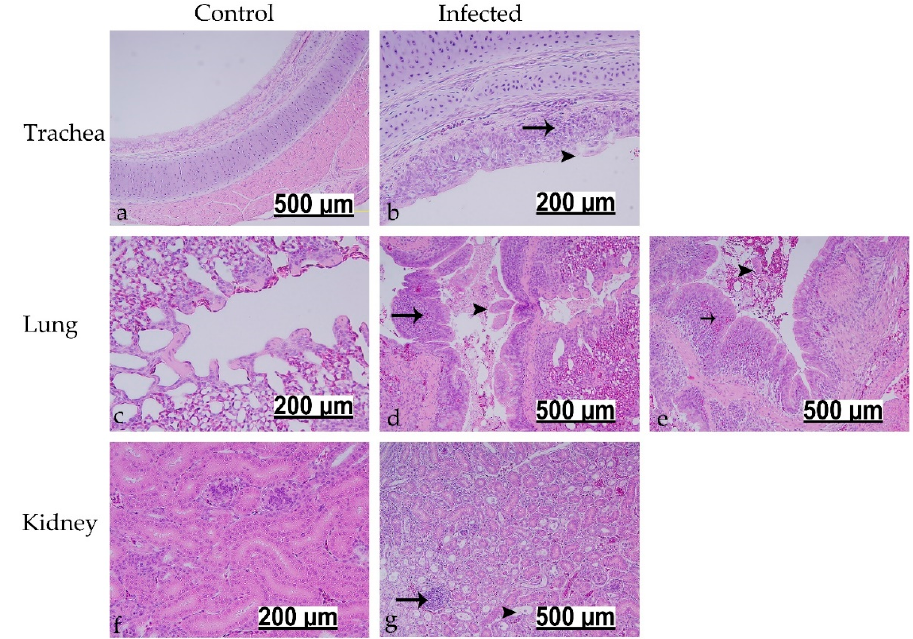
Figure 6. Histopathological changes detected in trachea, lung, and kidney at 7 dpi following infection at 1-day of age. ( a , c , f ) are controls. ( b ) Black arrowhead indicates epithelial desquamation and deciliation; black arrow shows mononuclear cells. ( d , e ) Black arrowheads refer to cellular exudate; long black arrow shows lymphoid aggregates; short black arrow reveals heterophilic infiltration. ( g ) Black arrow indicates interstitial focal lymphoplasmacytic cells; black arrowhead shows dilated renal tubules.